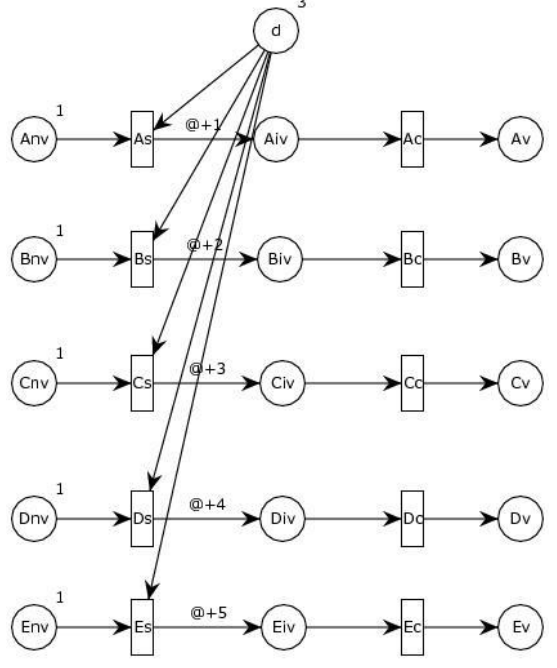
Figure 13. Five cities connected through depo. Figure 14. Five cities connected through